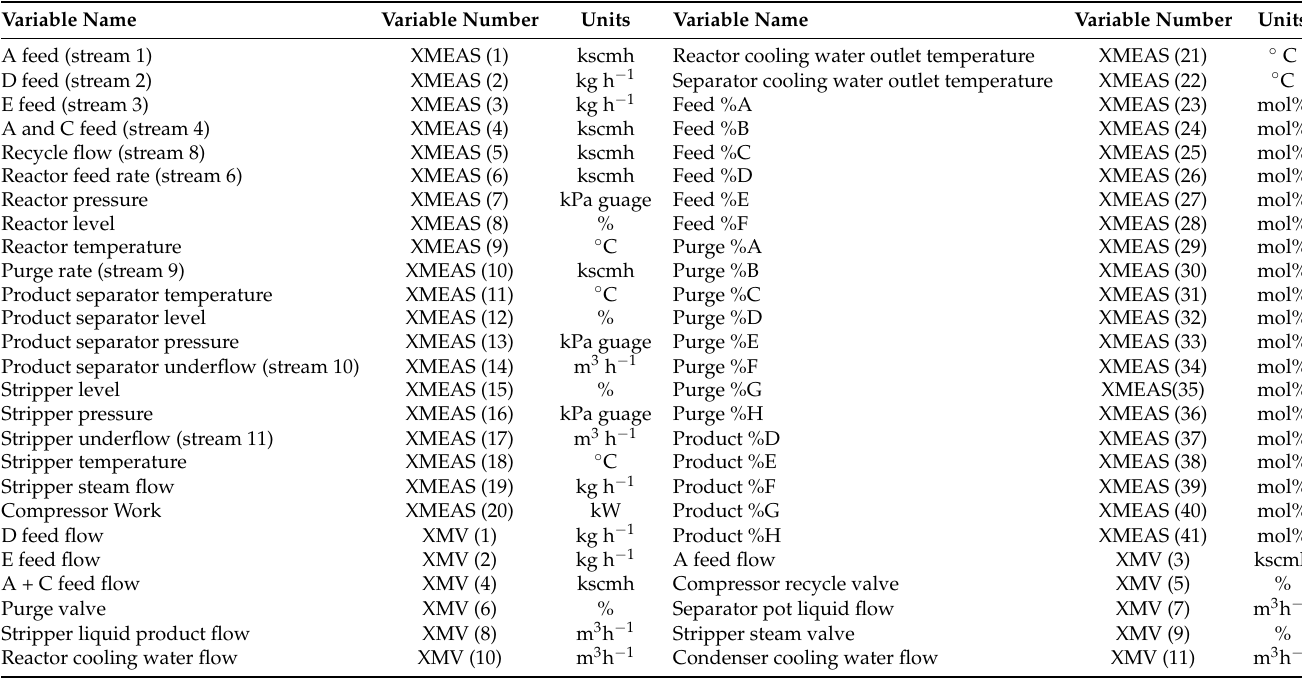
Table 1. Measured and manipulated variables (from Downs and Vogel, 1993).